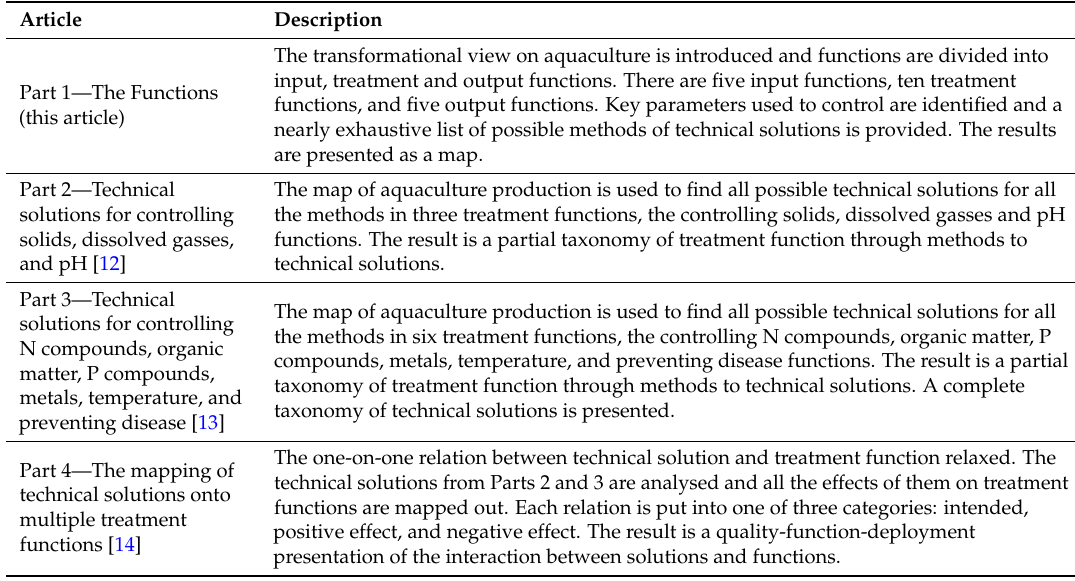
Table 2. Overview of the whole study, showing the contents of each article and how they all together create a holistic approach to aquaculture